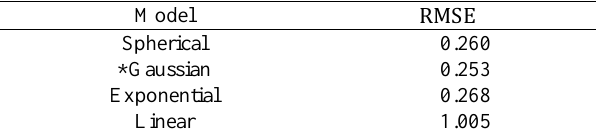
Table 9. Rresults of different variogram